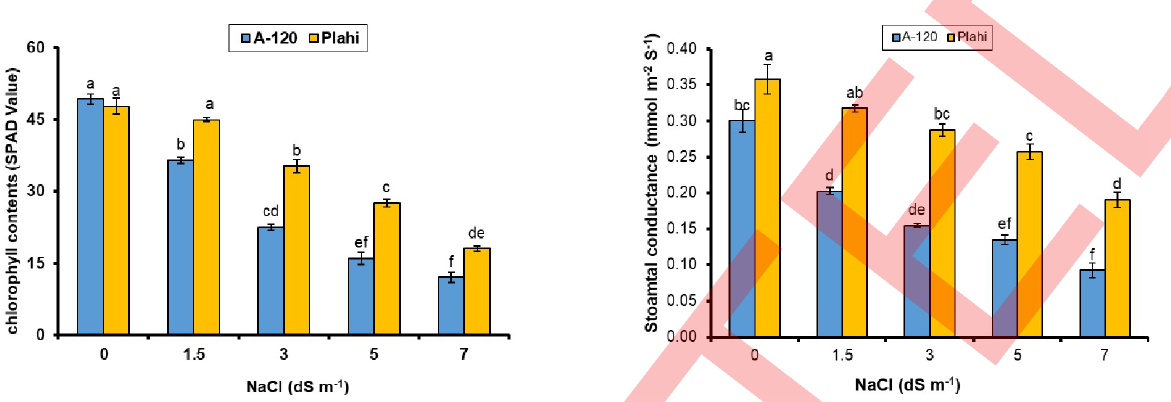
Fig 5. Effect of NaCl Salt stress on stomatal conductance (Ci) and chlorophyll contents (SPA value) of two chili genotype.